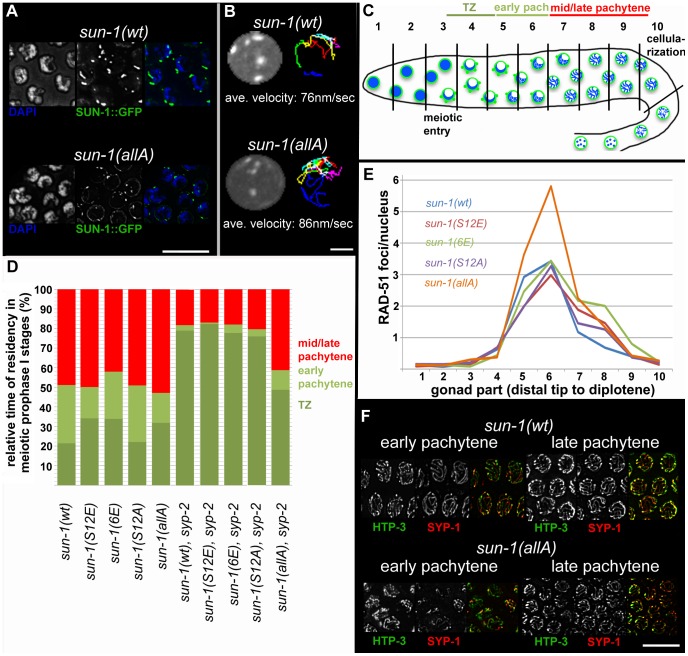
Effect of sun-1 phosphosite mutations on the duration of meiotic stages, DSB turnover, SUN-1 aggregates, chromosome movement, and synapsis.(A) TZ nuclei of sun-1(wt); sun-1(ok1282) (top), and sun-1(allA); sun-1(ok1282) (bottom) hermaphrodite gonads stained with DAPI (left; blue in merged picture) and anti-GFP (middle; green in merged picture). Scale bars, 10 µm. (B) First frame of in vivo time-lapse GFP-recorded TZ nuclei of sun-1(wt); sun-1(ok1282) (top, left) and sun-1(allA); sun-1(ok1282) (bottom, left) hermaphrodite gonads. Displacement tracks of SUN-1 aggregates represent 2D plotted chromosome end movements over 3 min (right). Average speed of SUN-1 aggregates in TZ (n = 9 nuclei, followed over 3 mins). Scale bar, 2 µm. (C) Schematic of a wild-type hermaphrodite gonad with nuclei in the corresponding zones, as used in the quantifications in Figure 3D: chromatin (blue) and SUN-1 morphology (green). Gonad is subdivided into ten zones, as used for the RAD-51 foci quantification in Figure 3E. Meiotic entry and beginning of cellularization are indicated. (D) Representation of relative time of residency in different meiotic stages, as assessed by presence of SUN-1 aggregates in different mutant backgrounds, normalized to the length of the gonad (from meiotic entry [0%] to start of meiocyte cellularization at diplotene [100%]). Nuclei were sorted into three categories: “TZ” (dark green, more than one SUN-1 aggregate), “early pachytene” (light green, one SUN-1 aggregate), and “late pachytene” (red, no SUN-1 aggregate). Categories were assigned once ≥50% of nuclei in a cell row fulfilled one of these criteria. At least eight gonads were counted per genotype. (E) Average numbers of RAD-51 foci per nucleus in the hermaphrodite gonad of different sun-1 phosphosite mutants. Gonads were divided into ten zones, as schematically indicated in (B). Three gonads per genotype were counted. (F) Nuclei from early and late pachytene zones of sun-1(wt); sun-1(ok1282) (top) and sun-1(allA); sun-1(ok1282) (bottom) hermaphrodite gonads stained with anti-HTP-3 (left, green in merged) and anti-SPY-1 (middle, red in merged). Scale bars, 10 µm.